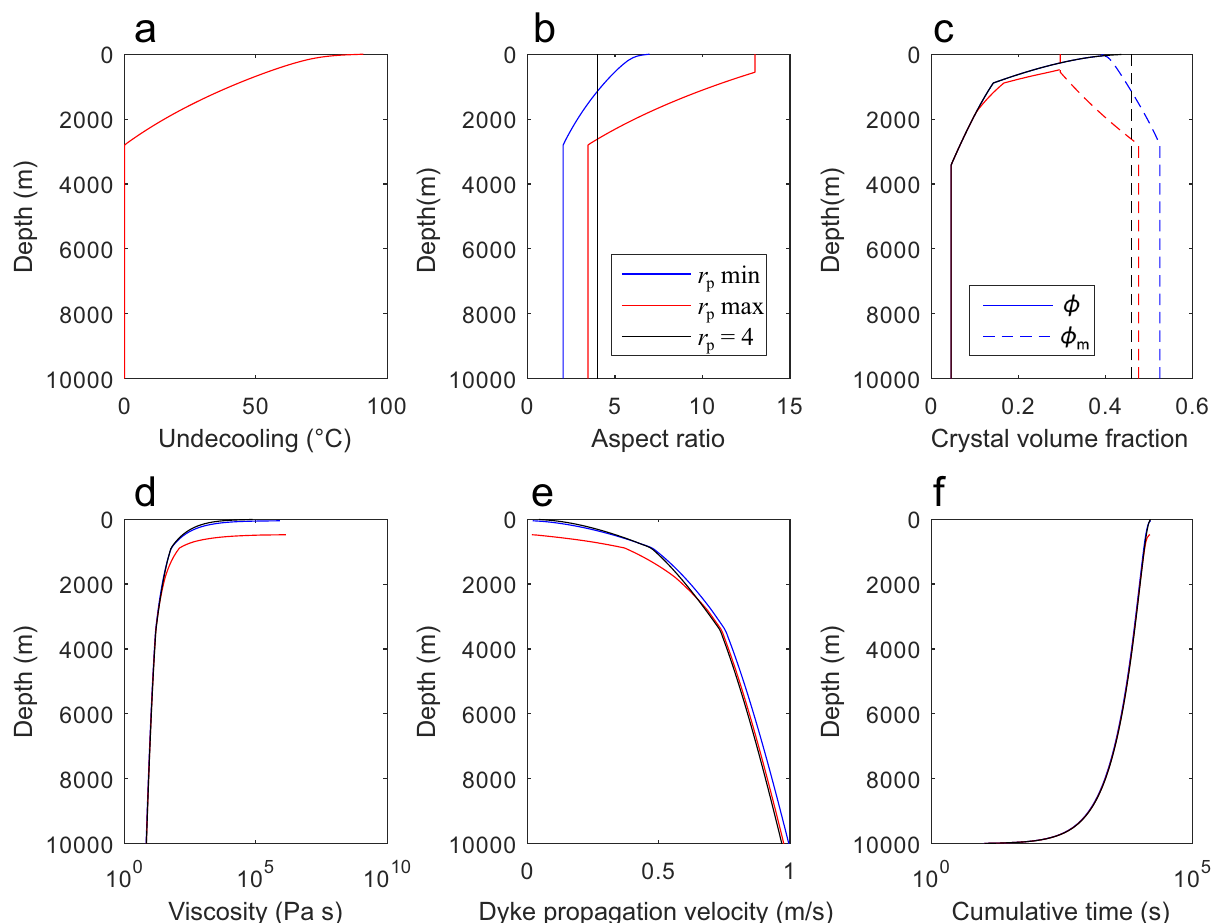
Fig. 6 Model results during dike propagation towards the surface. Plots of magma ascent dynamics within a dike in which the cooling rate during ascent is 2 × 10 − 3 °C s − 1 . a Undercooling ( Δ T ) as a function of depth. b Crystal aspect ratio as a function of Δ T . c Crystal volume fraction as a function of Δ T . The solid lines represent the crystal volume fraction ( ϕ ), whereas the dashed lines represent the maximum packing fraction ( ϕ m ). The red line represents the maximum aspect ratios achievable at Δ T ≥ 30 °C during dendritic crystal growth and considers the entrapment of melt between branches that further increases the crystal volume fraction. d Magma viscosity as a function of depth. e Dike propagation velocity as a function of depth. f Time needed to propagate dike from 10 km to the depths where the ϕ m is met. Data plotted in Fig. 6 are provided in the Supplementary Data